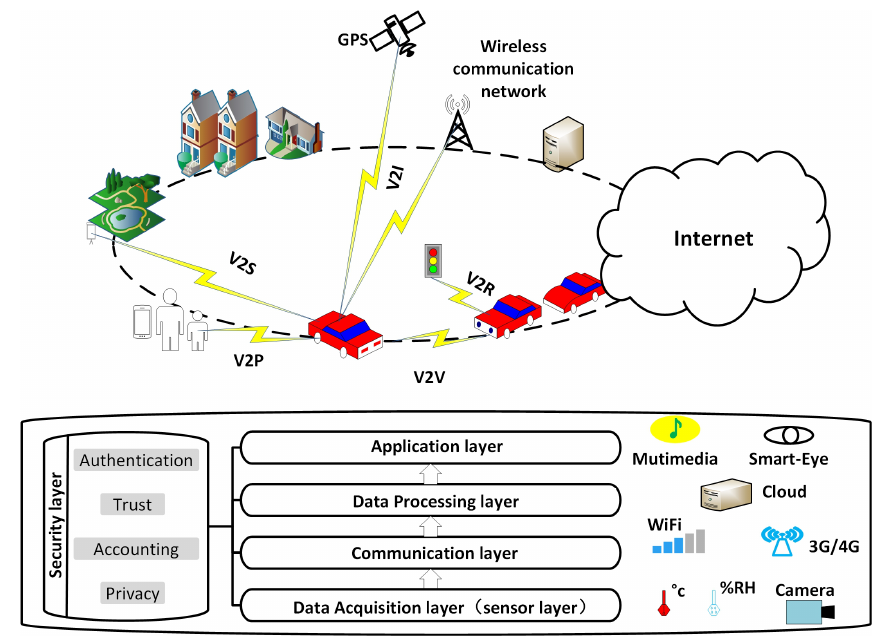
Figure 2. Diagram of